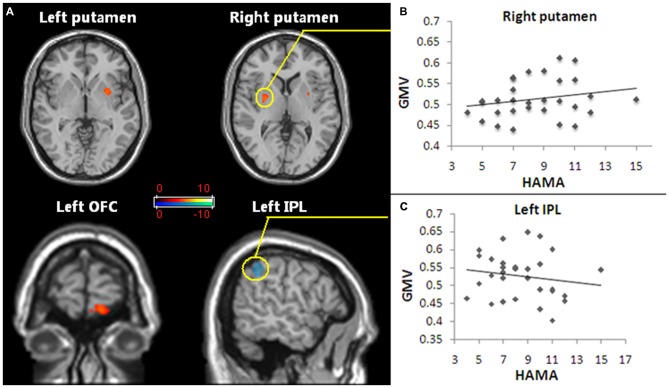
Regions of gray matter volume (GMV) abnormalities exhibited in pediatric obsessive-compulsive disorder (OCD) patients and the GMV abnormalities correlated with anxiety symptoms. (A) The red and white voxels reveal the brain areas in which the GMV increased in pediatric OCD, and the blue and green voxels demonstrate reduced GMV regions in pediatric OCD. The regions with increased GMV included the bilateral putamen and the left orbitofrontal cortex (OFC). Reduced GMV included the left inferior parietal lobule (IPL). Statistical significance was assumed with p < 0.05 after family-wise error (FWE) correction with a minimum cluster size of 50 voxels (with age, gender and whole brain volume as covariates). (B) The increased GMV in the right putamen (the region in the yellow circle) of the pediatric OCD group was positively correlated with HAM-A scores (p < 0.05, r = 0.44). (C) The decreased GMV in the left IPL (the region in the yellow circle) of the OCD group show a trend of was negatively correlated with HAM-A scores (p = 0.051, r = −0.39). Abbreviations: FWE, family-wise error; GMV, gray matter volume; OCD, obsessive-compulsive disorder; OFC, orbitofrontal cortex; IPL, inferior parietal lobule.